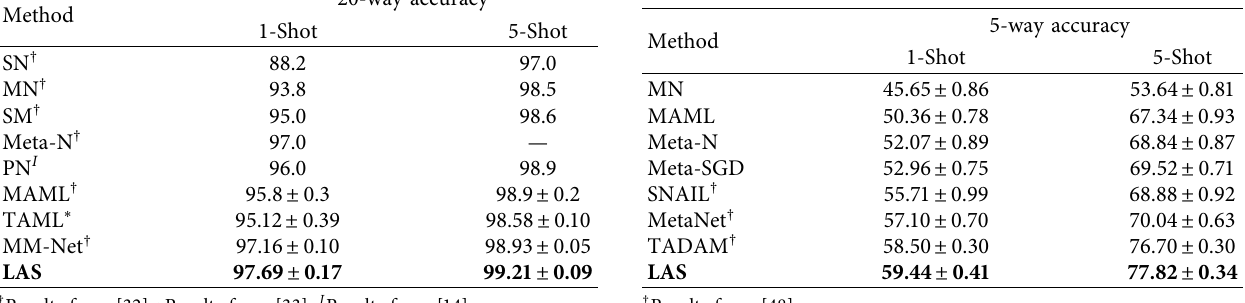
Table 5: Mean accuracy (%) ± CIs (%) of 7 state-of-the-art methods and LAS on the mini-ImageNet dataset with ResNet-12 as the backbone.